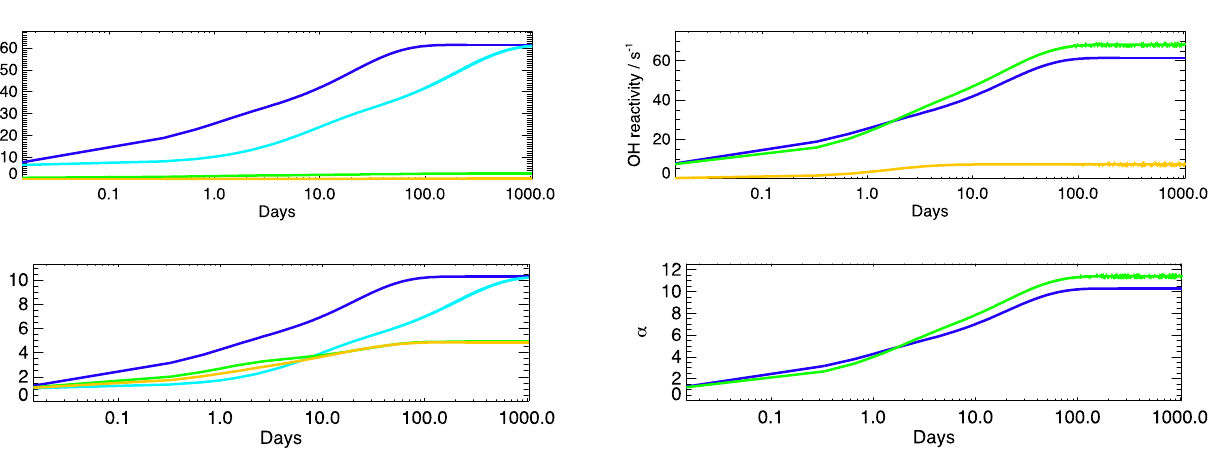
be why the gradient observed in Fig. 5 is as high as 2 but why it is as low as 2.